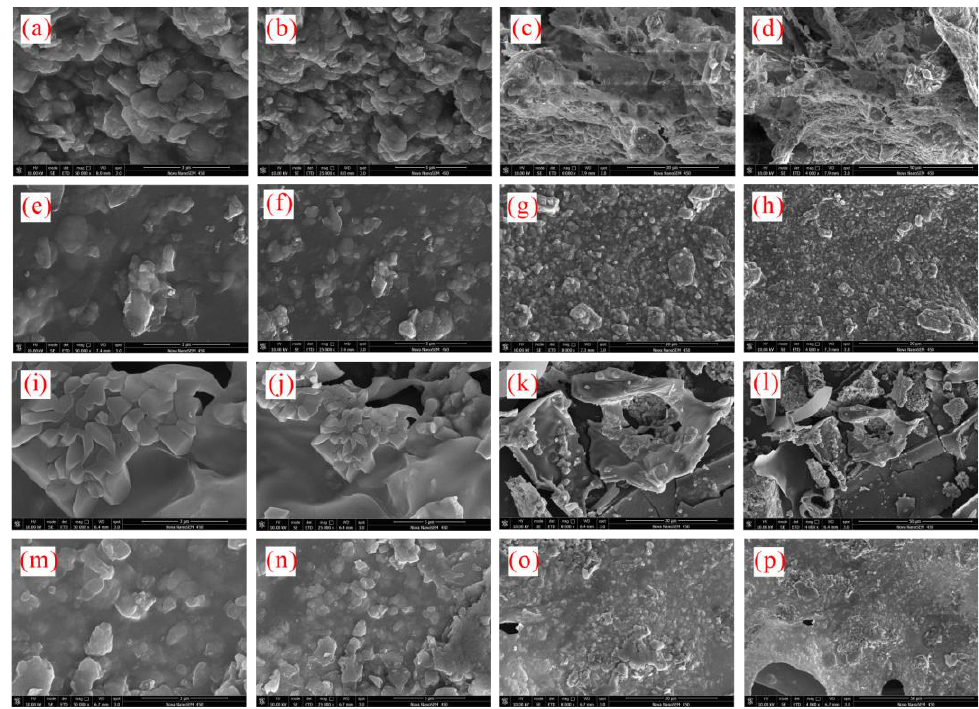
Figure 9. Meso-structures of lyophilized samples of xanthan gum and pectin sediment solutions: ( a – d ) 0.1 wt% xanthan gum; ( e – h ) 0.5 wt% xanthan gum; ( i – l ) 0.1 wt% pectin; ( m – p ) 0.5 wt% pectin. Table 2. Elemental content of filter cakes of xanthan gum and pectin sediment